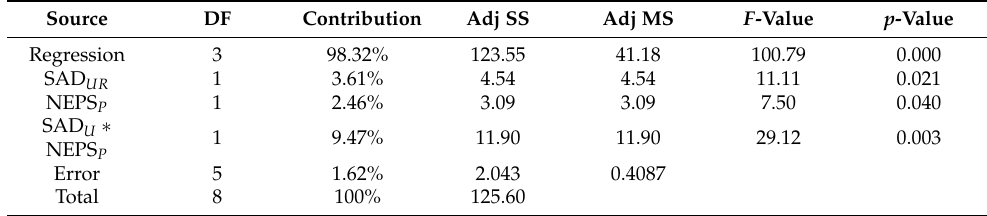
Table 2. ANOVA results for the Use restroom PLSR